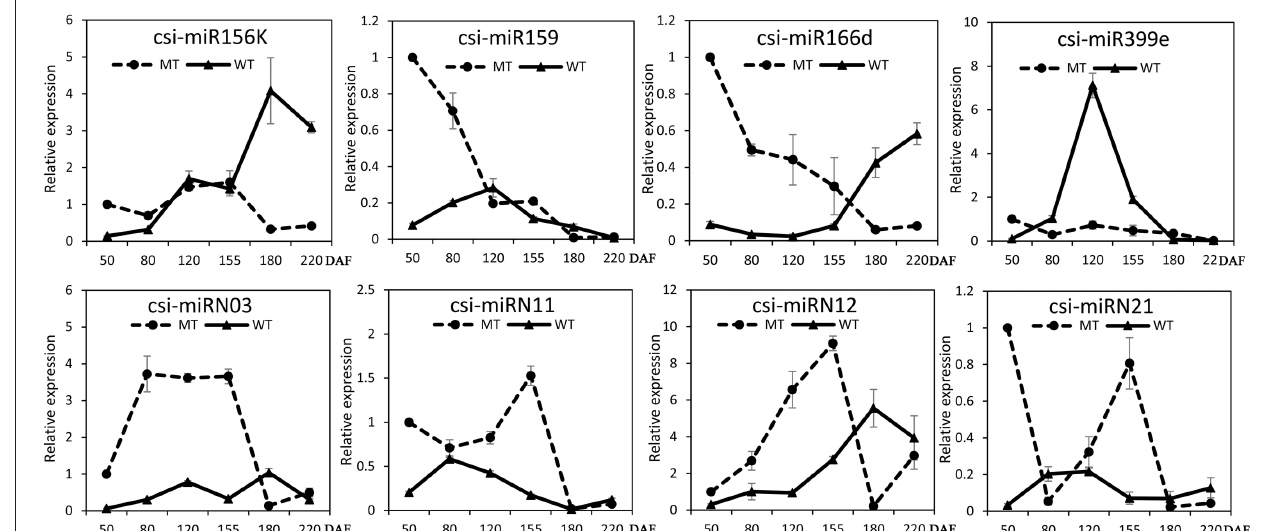
FIGURE 4 | Expression patterns of several candidate miRNAs in MT and WT during fruit development and ripening. The relative expression levels were obtained from stem-loop